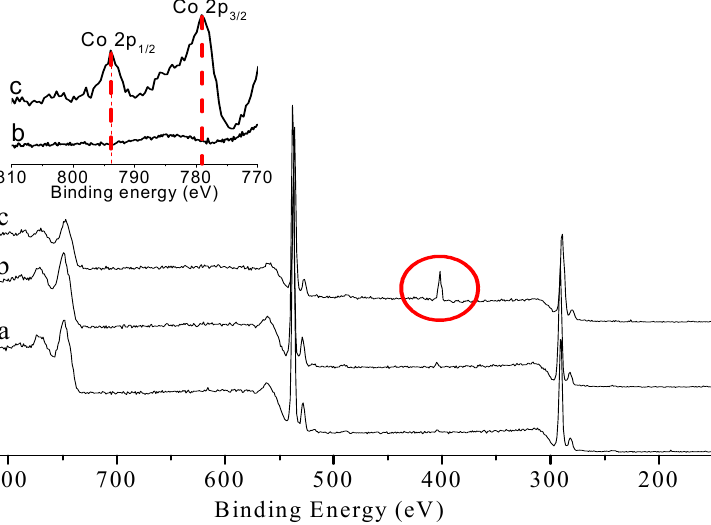
Figure 3. XPS spectra of ( a ) BC; ( b ) oxidized BC; and ( c ) CoPc@BC. The window included shows, in detail, the Co region.